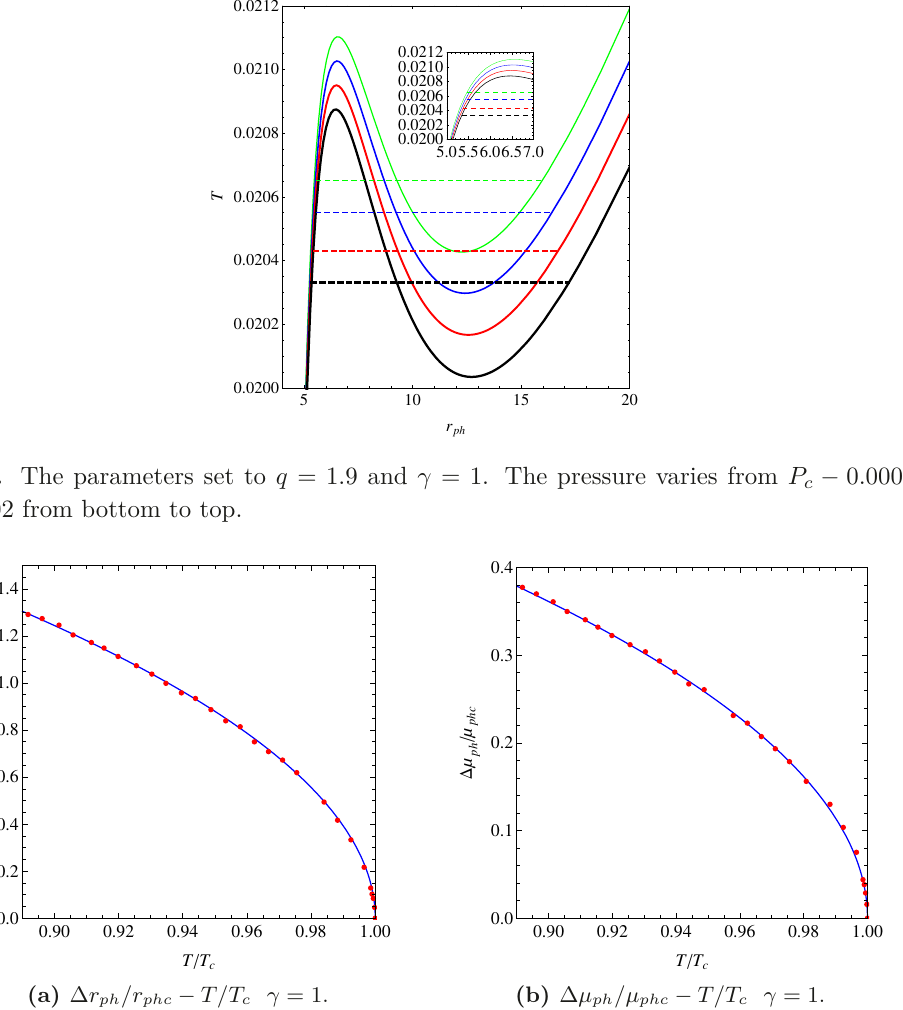
Figure 10. The YM charge set to q = 1 .